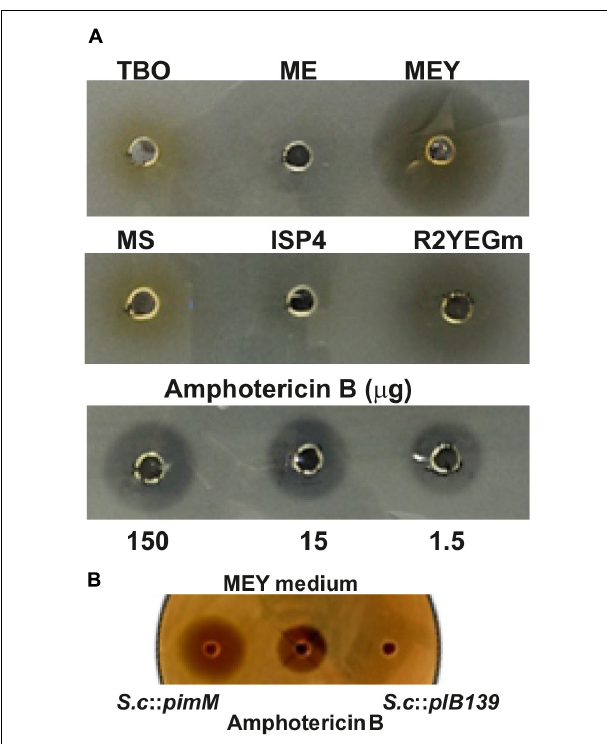
FIGURE 4 | Bioactivity of S. clavuligerus :: pimM and S. clavuligerus ::pIB139 extracts against C. utilis . (A) Bioassay of concentrated extracts from S. clavuligerus :: pimM grown on TBO, ME, MEY, MS, ISP4, and mR2YEG solid media. The media assayed are indicated on top of the bioassay wells. Amphotericin B (150, 15, and 1.5 µ g) was used as bioassay positive control. (B) Bioassay of concentrated extracts from S. clavuligerus :: pimM (left) and S. clavuligerus ::pIB139 (right) grown in MEY medium and amphotericin B (150 µ g) used as bioassay positive control